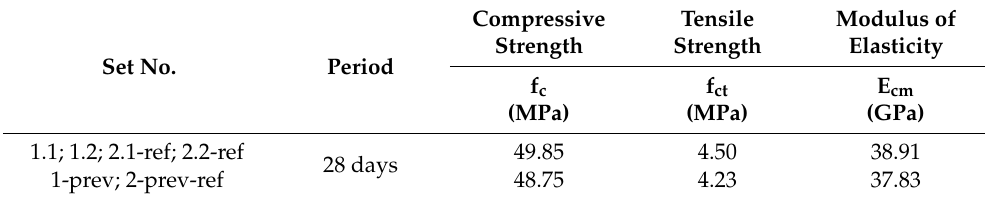
Table 3. Mechanical characteristics of concrete used for the specimens.